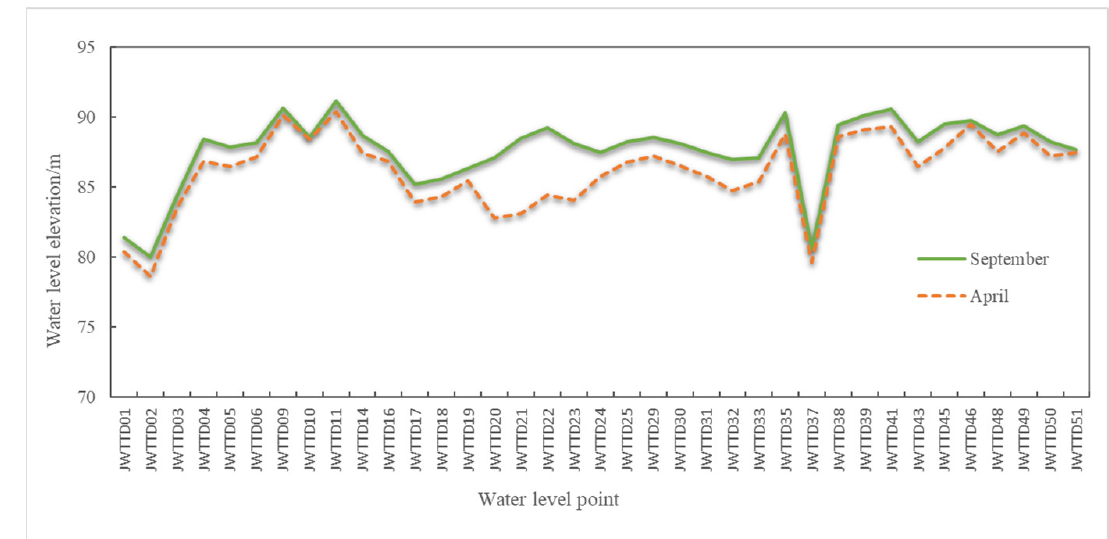
Figure 5. The groundwater level fluctuation map of different periods.